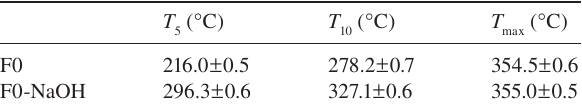
Table 2 Thermal properties of alkali treated fl ax.